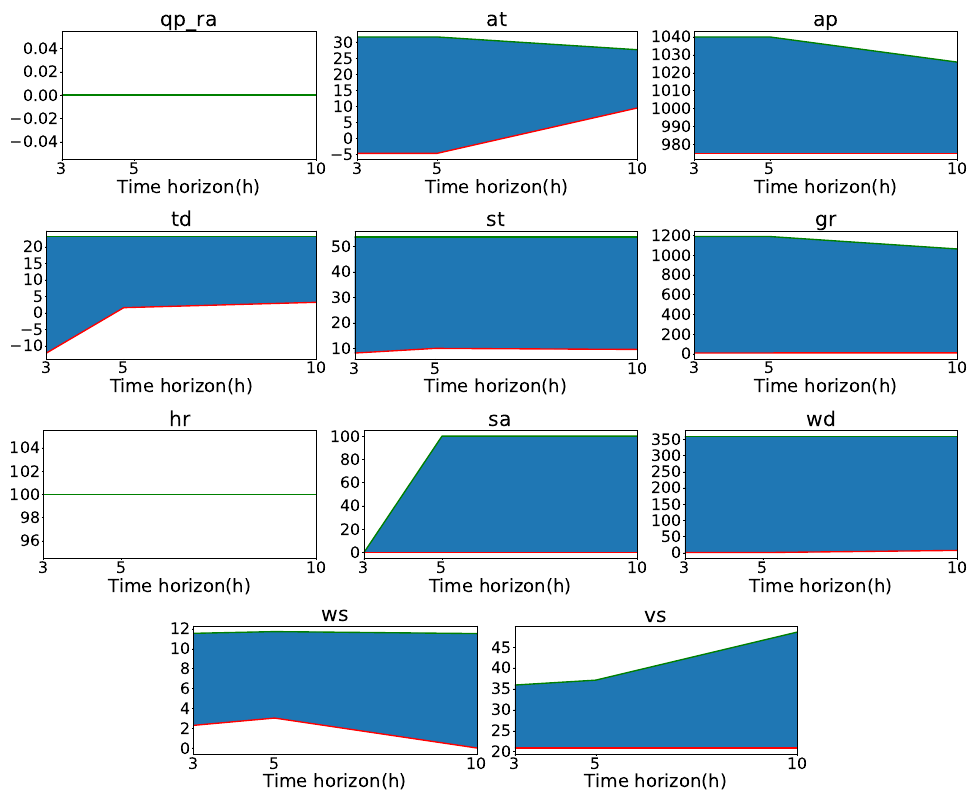
Figure 11. Evolution of the value ranges of each variable within the most restrictive box of each time